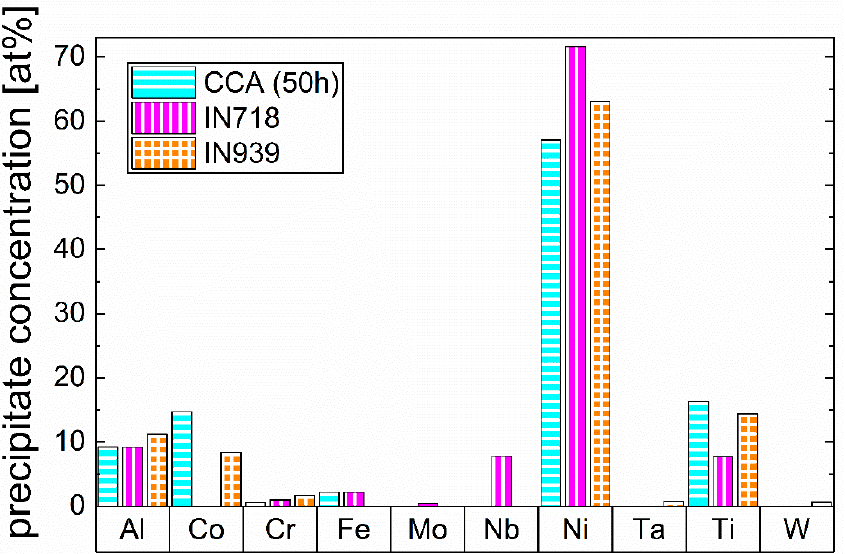
Figure 6. Comparison of the chemical composition of the precipitate phase of the CCA after 50 h of aging with the γ ’-composition of Ni-based IN718 [20] and IN939 [21] alloys from the literature.